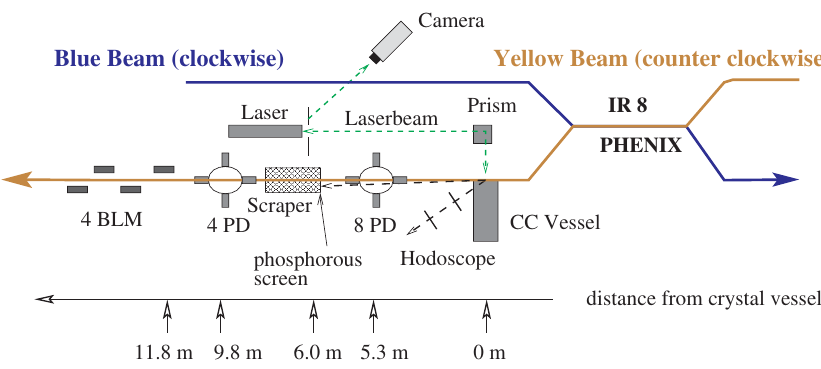
FIG. 5. (Color) RHIC crystal collimation system. The center of RHIC is toward the bottom of the